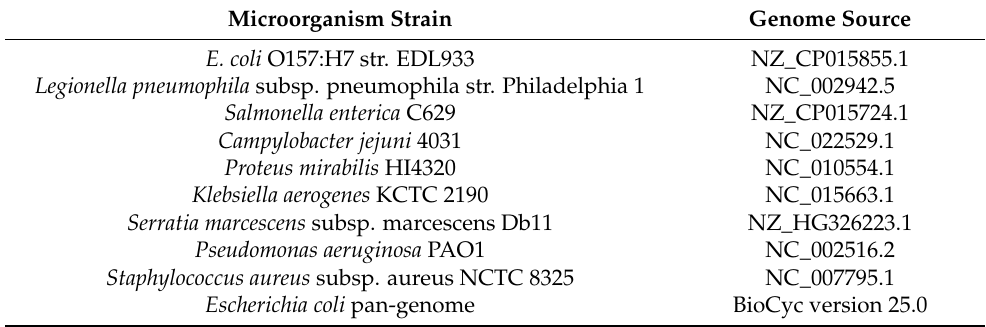
Table 1. Selection of common microorganisms occurring in drinking water for bioinformatic